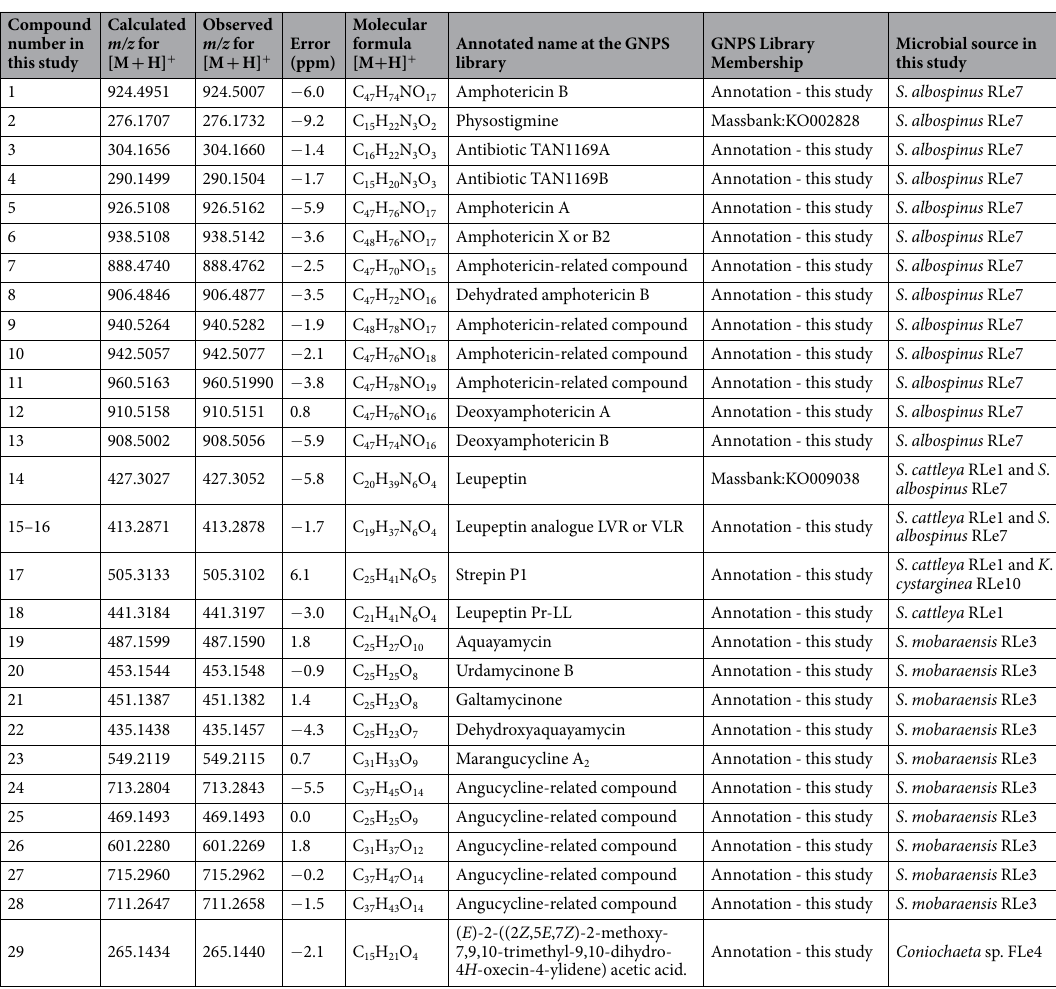
Table 1. Summary of identified compounds in this